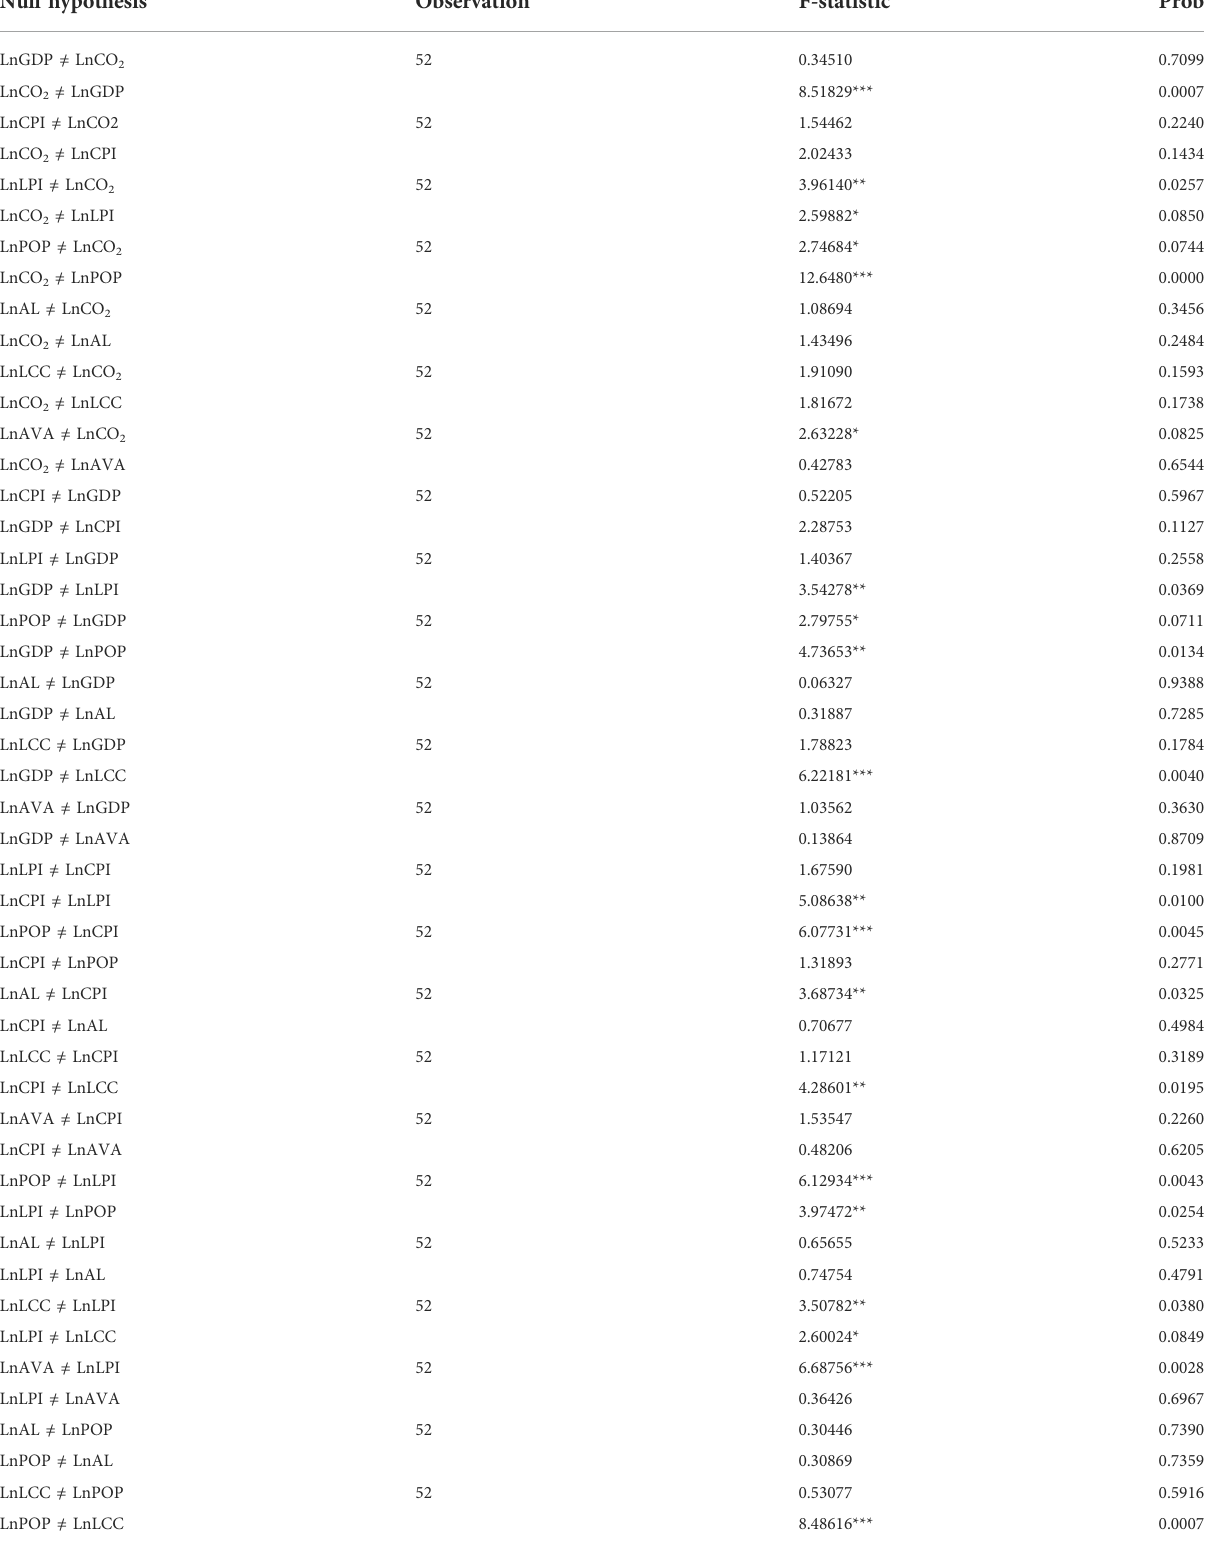
TABLE 10 Pairwise Granger causality